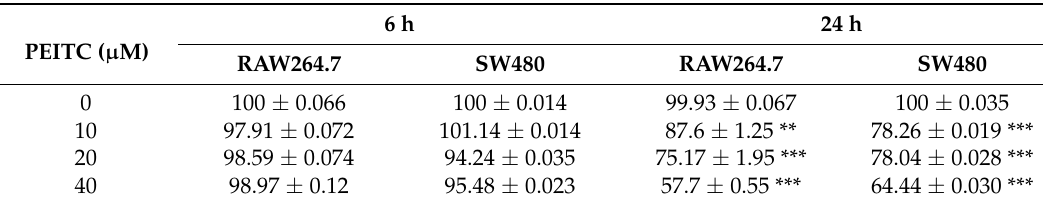
Table 1. Effect of PEITC on cell viability after 6 and 24 h exposure.